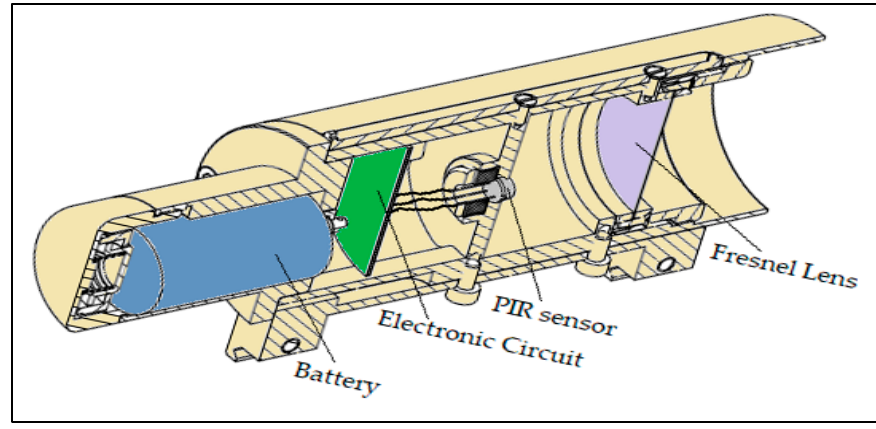
Figure 3. PIR sensor module